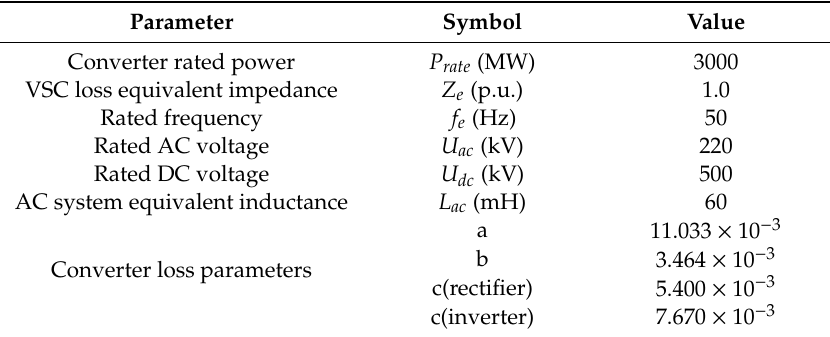
Table 1. The parameters of the AC-DC system model.